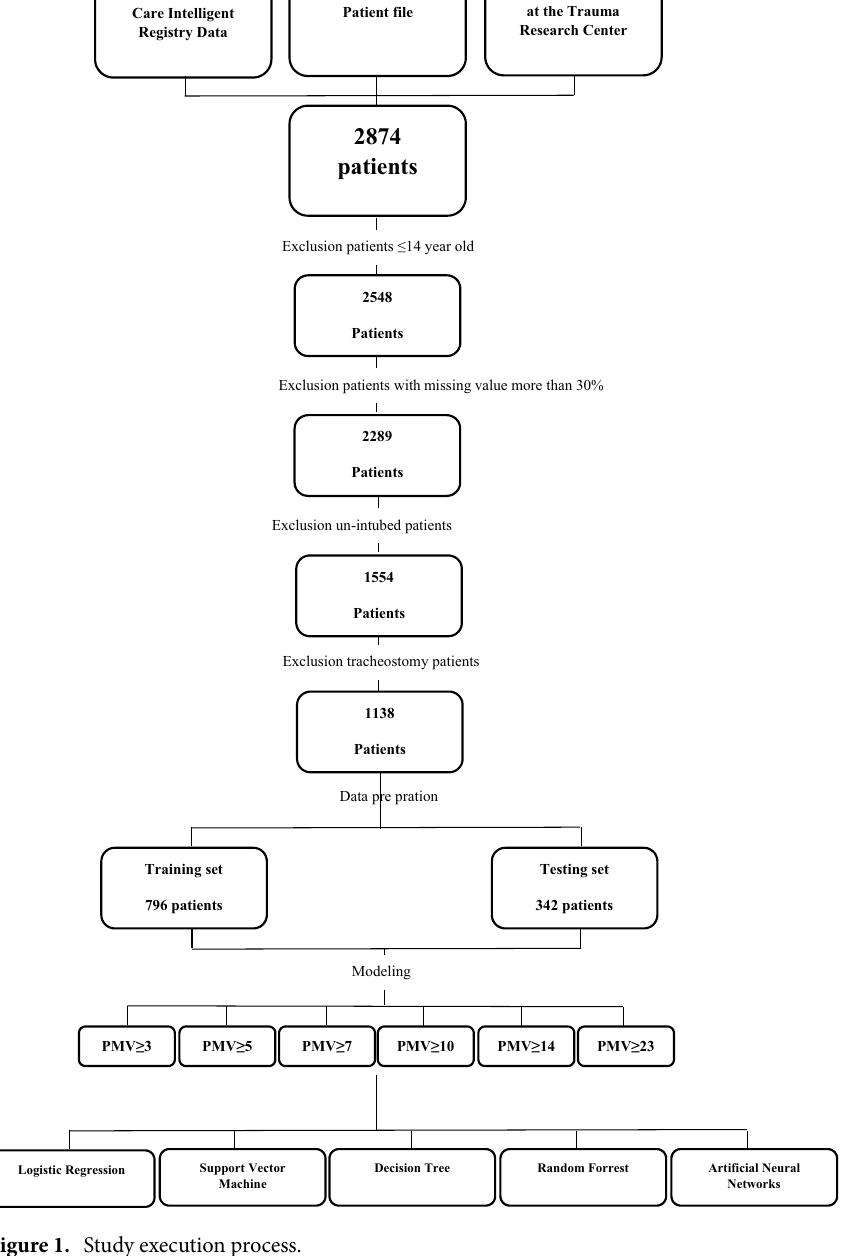
Figure 1. Study execution